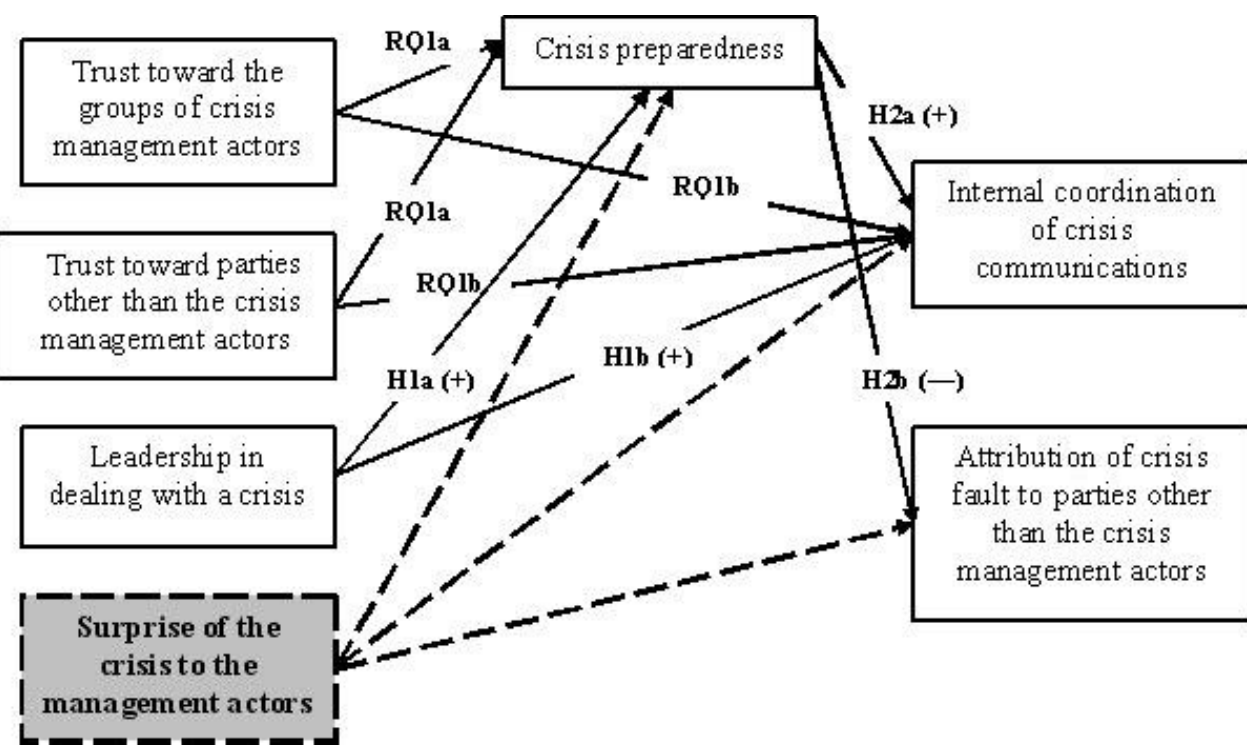
Fig. 2. Model B: Proposed model of crisis communication management controlling for crisis surprise, with hypothesis